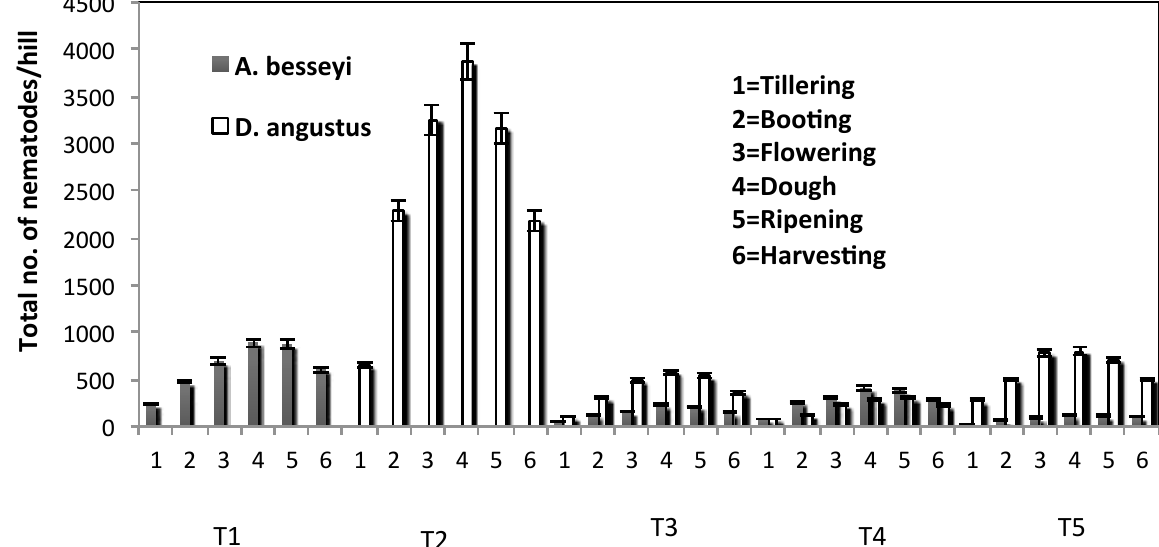
Figure 1B. Population dynamics of Aphelenchoides besseyi and Ditylenchus angustus at different rice plant growth stages in the field experiment 2003 to 2004. Treatment (T), A. besseyi : D. angustus inoculation ratios, T1 = 100:0; T2 = 0:100; T3 = 50:50; T4 = 75:25; T5 = 25:75]. Vertical bars indicate standard errors.